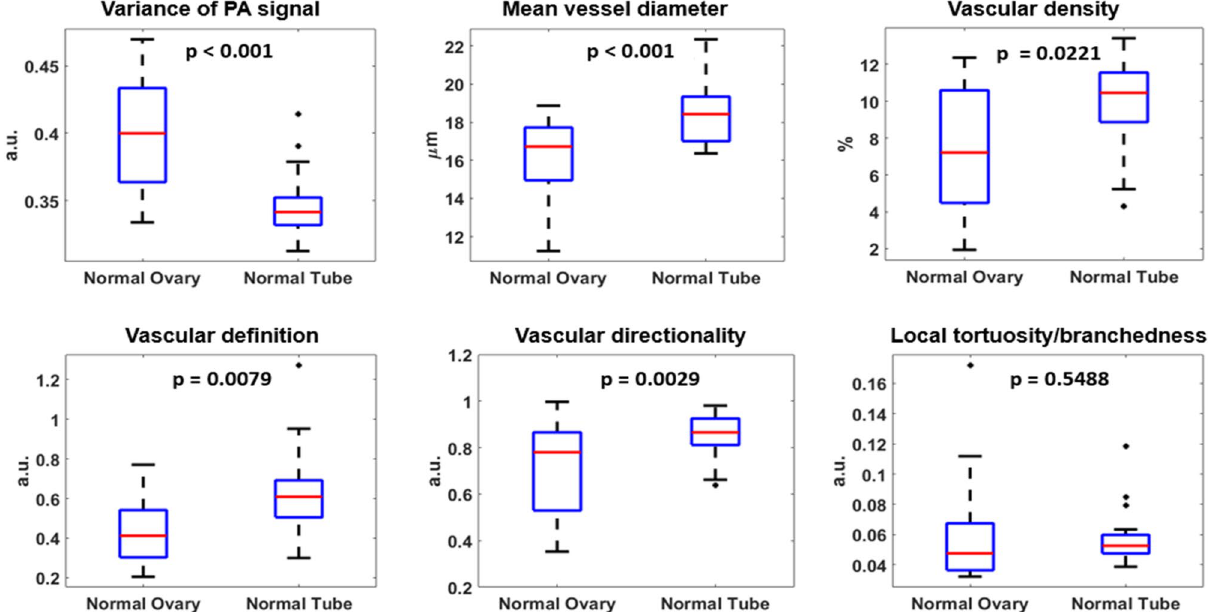
Figure 4. Comparison of morphological vascular feature differences between normal ovaries (n = 10) and normal fallopian tubes (n =